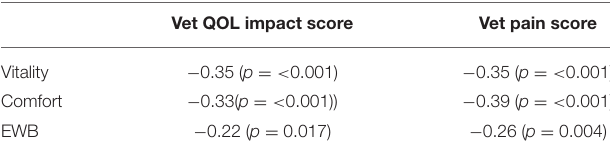
TABLE 3 | Pearson correlation coefficients and respective P values for the reported comparisons between Vitality, Comfort and Emotional Wellbeing (EWB), and the vet-assessed pain and QOL impact